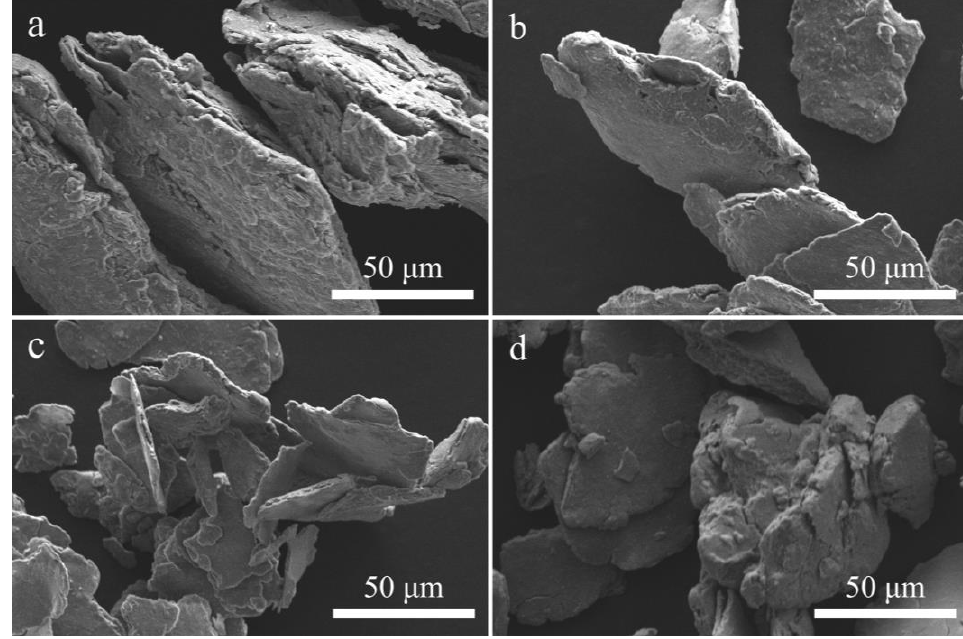
Figure 3. SEM images of Al-15 wt% BiOI at a ratio of ball to powder of 60:1 with ball milling for 1 h ( a ), 3 h ( b ), 5 h ( c ) and 7 h ( d ).